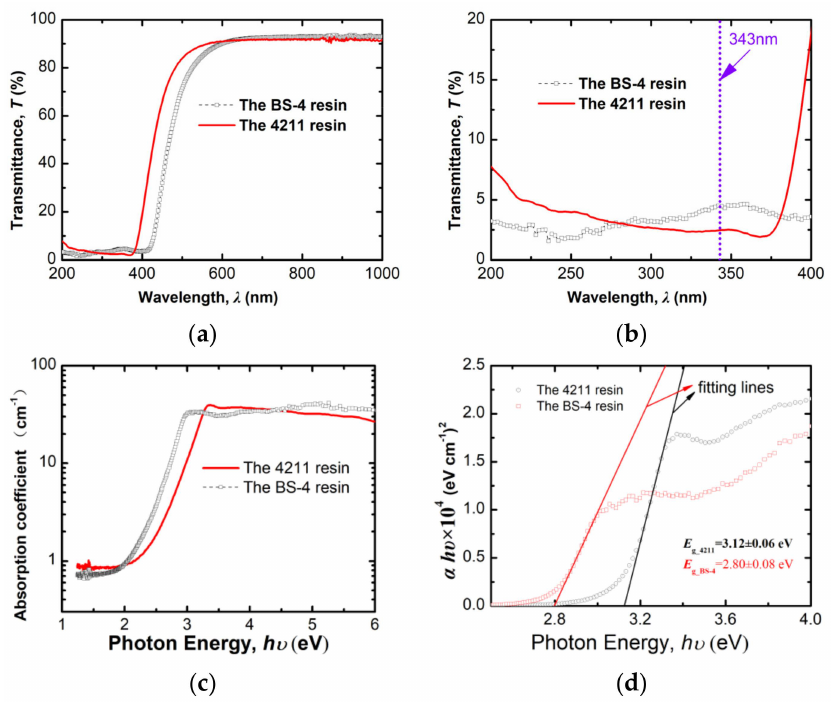
Figure 2. ( a ) Transmission spectrum at 200 nm − 1000 nm, ( b ) UV absorption edge, ( c ) Spectrum for absorption coefficient α , ( d ) Relationship between ( α h υ ) 2 and photon energy, h υ